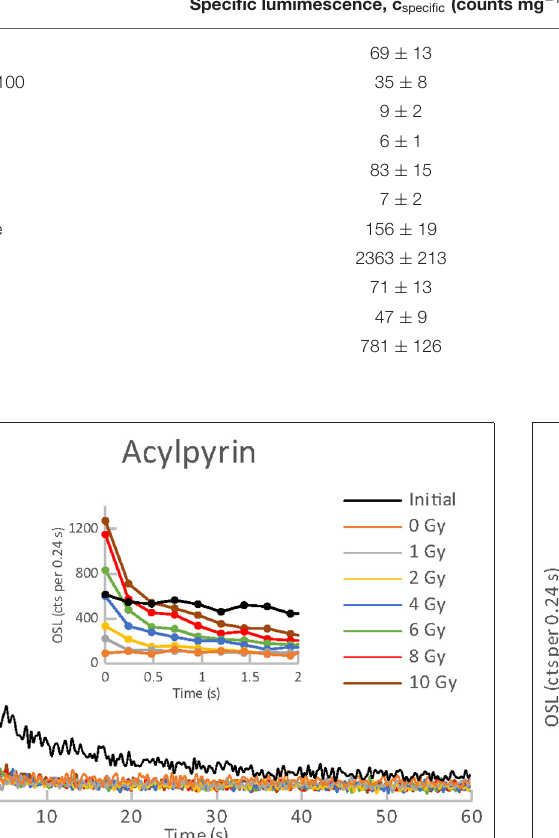
TABLE 3 | Specific luminescence, zero-dose and MDD values of all the materials. Sample